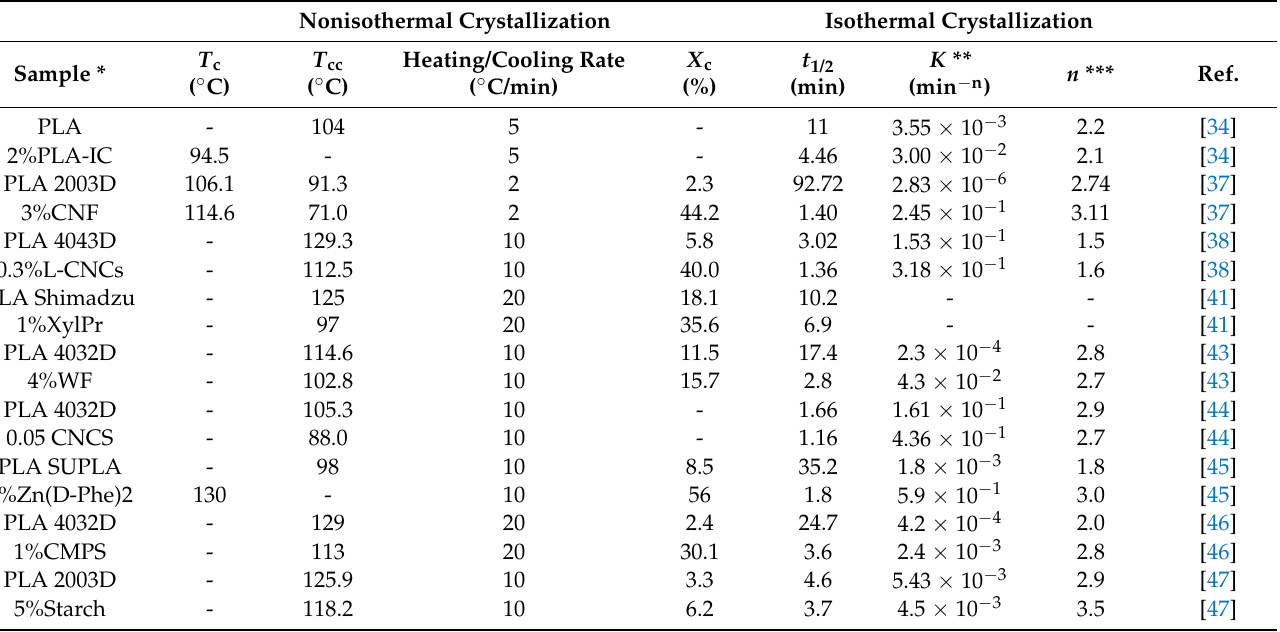
Table 3. Crystallization parameters of different PLA biomass nucleating agents during isothermal and nonisothermal